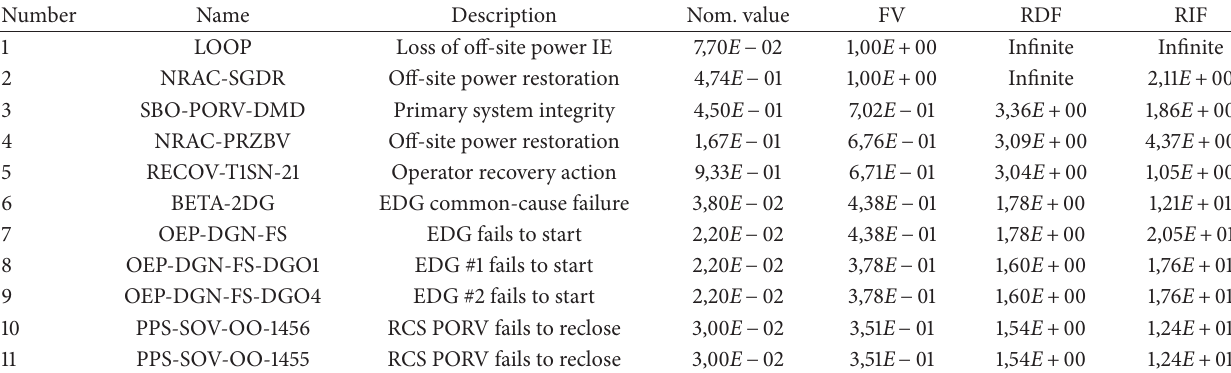
Table 11: Basic events with the largest FV importance measure in SBO event